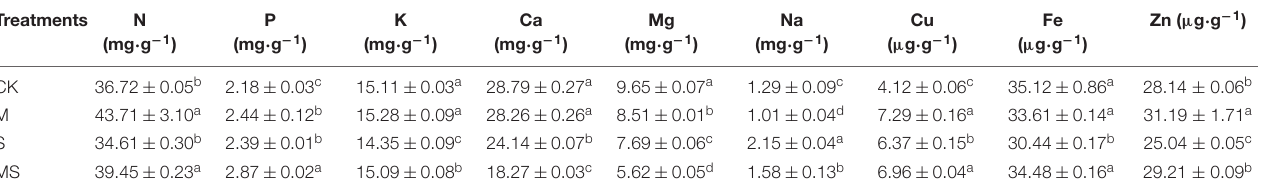
TABLE 3 | Elemental concentrations in leaves of watermelon inoculated (M, MS) or non-inoculated (CK, S) seedlings with AMF Funneliformis mosseae and subjected (S, MS) or not (CK, M) to salinity-alkalinity stress.